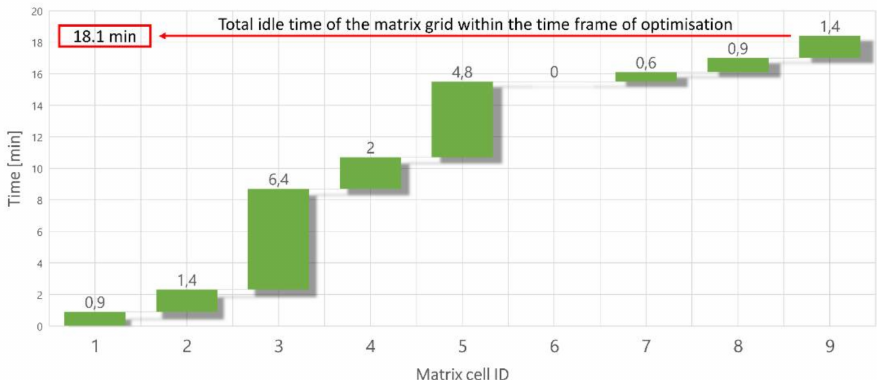
Figure 4. Idle time distribution among matrix cells within the cycle time of the 16 production orders in scenario